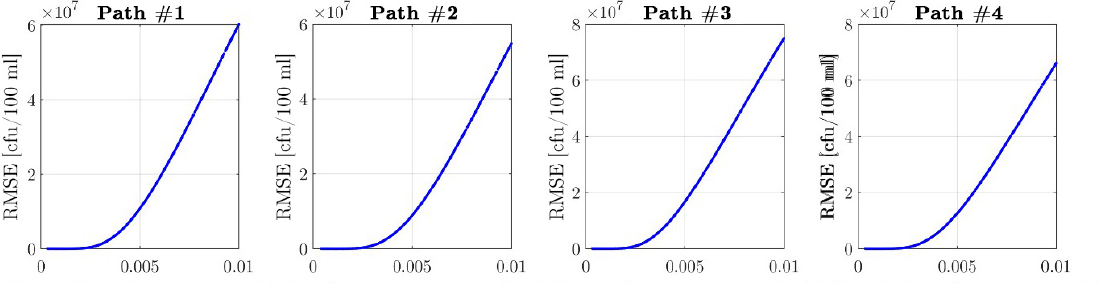
Figure 12. Sensitivity analysis based on root mean squared error (RMSE) (cfu/100 mL) for percolation velocity v VAD = 10 − 4 m/s − 10 − 2 m/s, for flow paths 1–4 towards the Jezerce well (from Figure